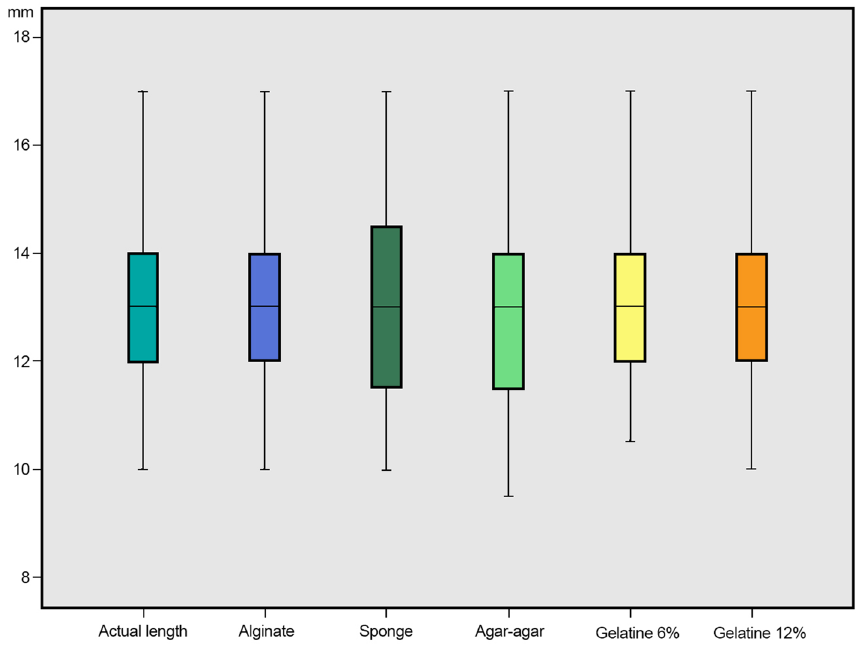
Figure 3. 100% box-and-whisker plot of the working length determination measurement results with the different embedding media investigated (mm; n = 110 per research group).